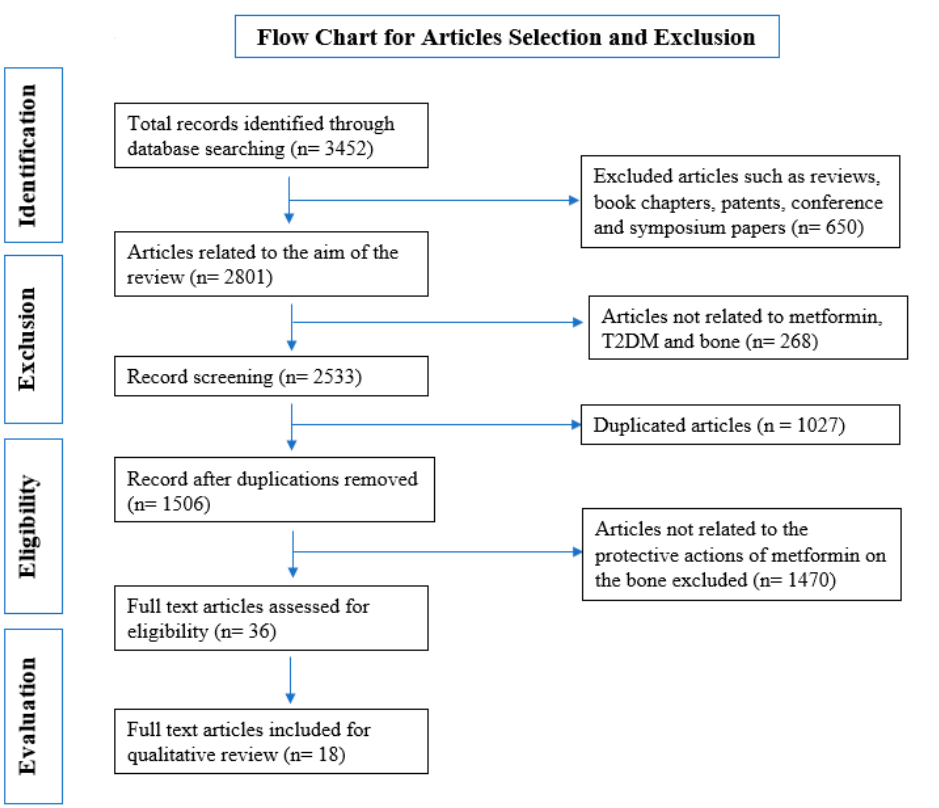
Figure 1. Flow chart of the study selection criteria based on the Preferred Reporting Items for Systematic Reviews and Meta-Analyses (PRISMA) guidelines.